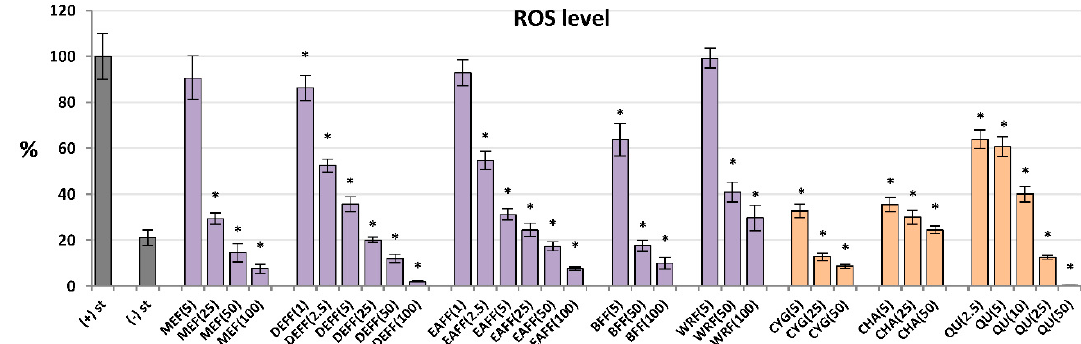
Figure 3. Effect of fruit extracts/fractions (1–100 µg/mL) and standards (5–50 µM) on the release of ROS, reactive oxygen species; Positive controls: QU, quercetin. For extracts codes see Table 1. Data expressed as means ± SD of five independent experiments performed with cells isolated from five independent donors. Statistical significance in Dunnett’s test: * p < 0.05 compared with the stimulated control.